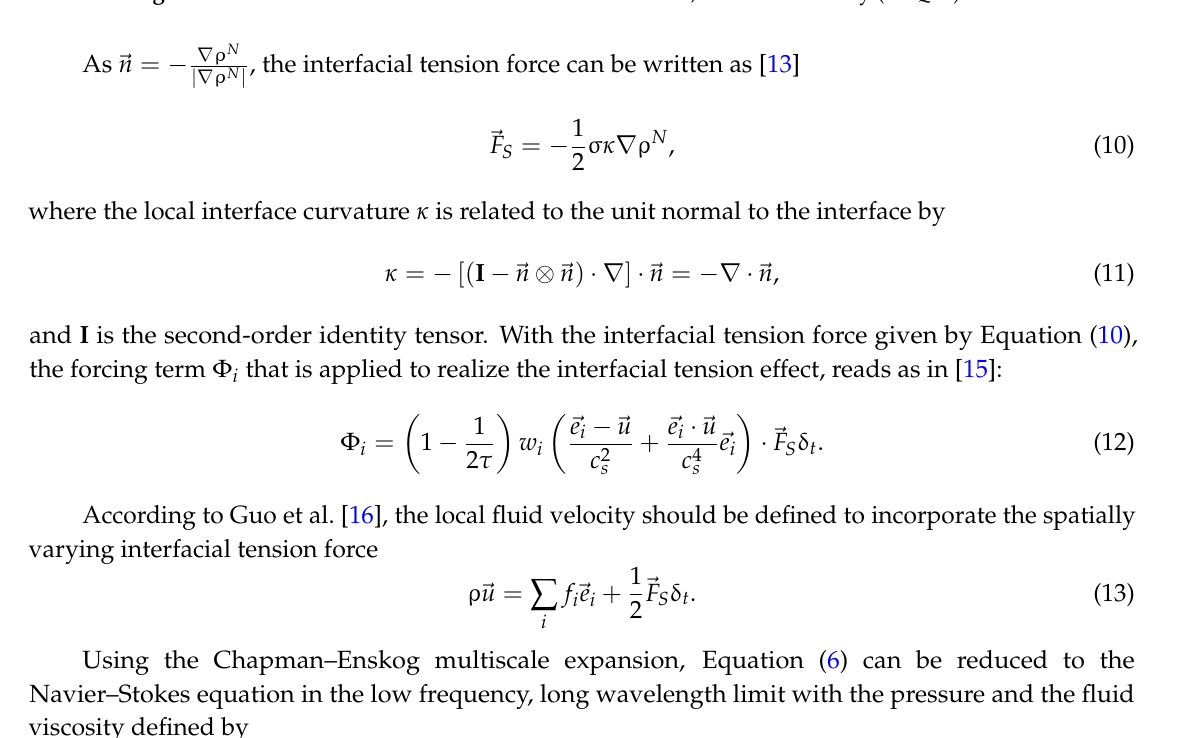
Figure 1. Schematic illustration of the three-dimensional, nineteen velocity (D3Q19)